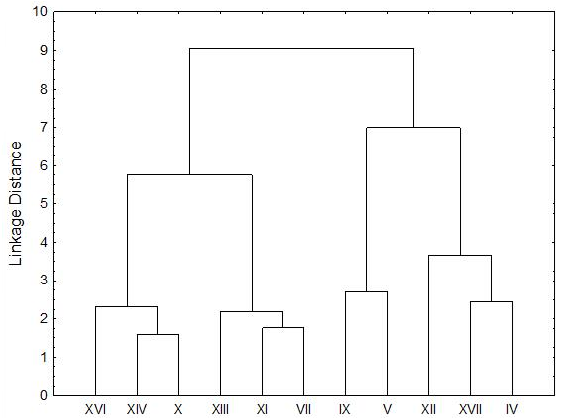
Figure 2. Dendrogram obtained from the evaluation of the mineral composition data by